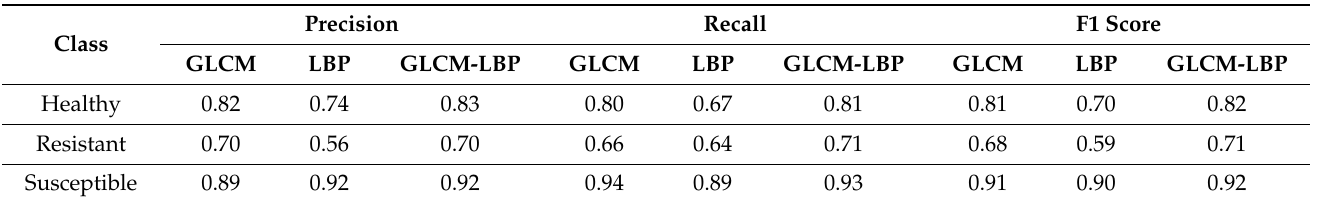
Table 2. Performance comparison for Decision Tree classification on GLCM, LBP, and Combined Textures GLCM-LBP